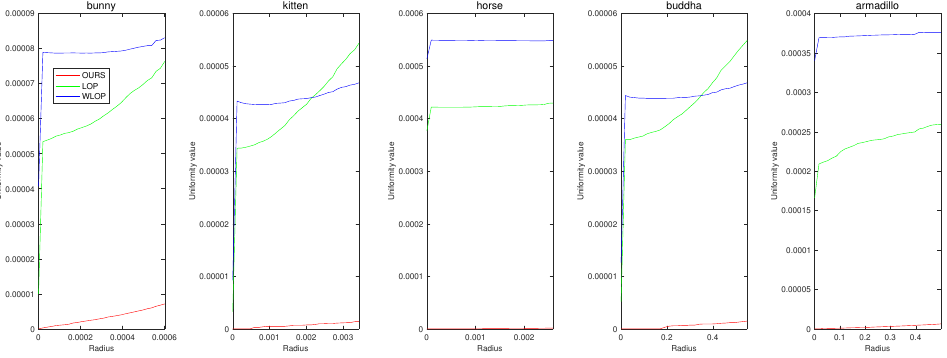
Figure 14. Quantitative results for the tangential noise cases with resampling ratio 2.0. Each column represents different input data (first column: Horse; second column: Bunny; third column: Kitten; fourth column: Buddha; and fifth column: